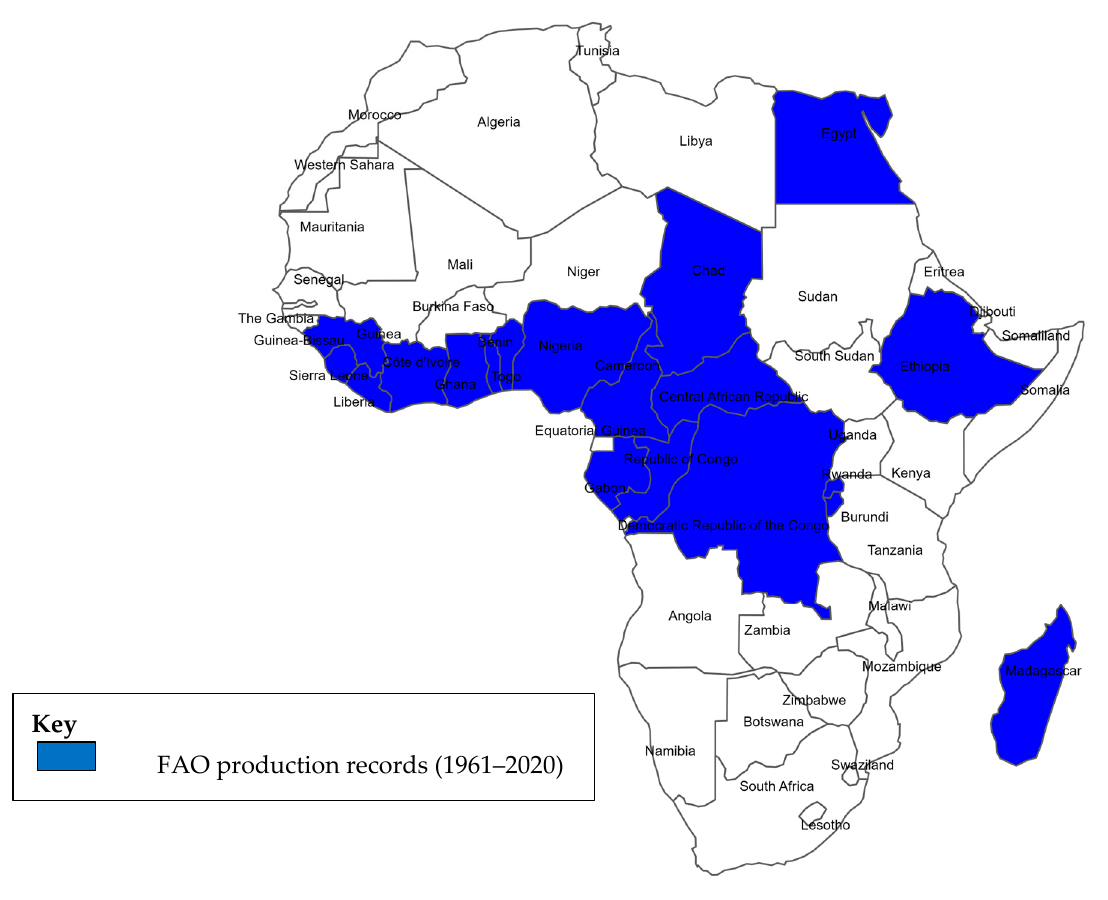
Figure 1. Map of taro production in Africa based on FAOSTAT data from 1961 to 2020.